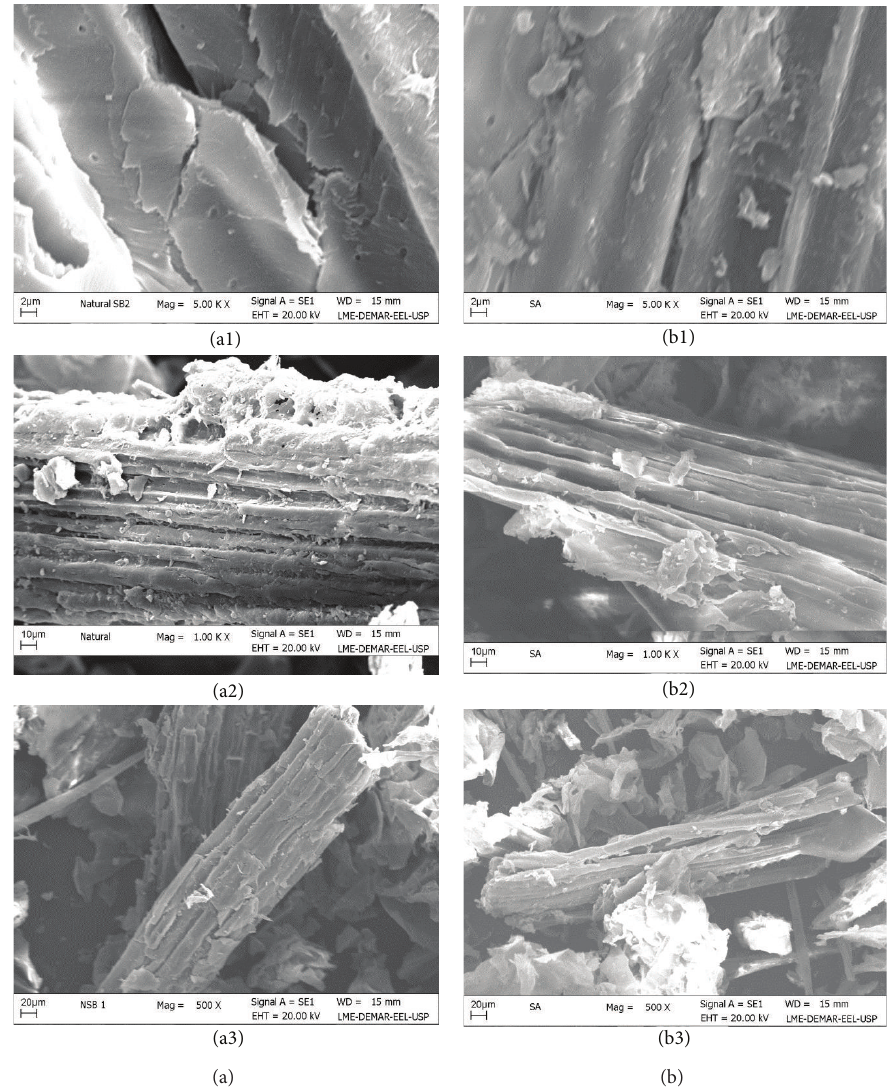
Figure 2: Scanning electron microscopic (SEM) analysis showing the surface images of sugarcane before (a) and after (b) dilute acid pretreatment (diluted H 2 SO 4 98%, 20 minutes at 121 ∘ C). (a1)/(b1), (a2)/(b2), and (a3)/(b3) are referents to a magnification of 500, 1000, and 5000x,